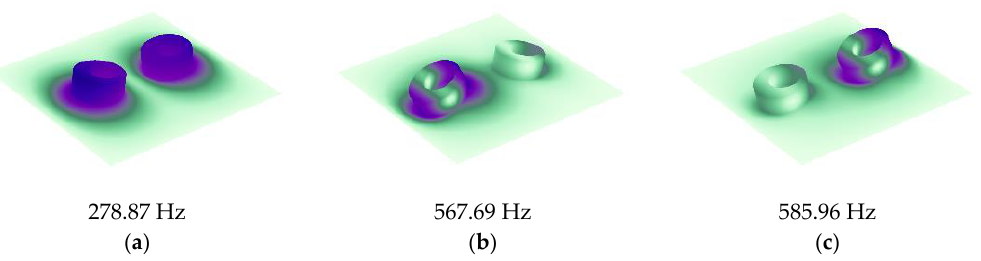
Figure 7. Eigenmodes of the double-mass-loaded membrane: ( a ) 278.87 Hz, ( b ) 567.69 Hz, and ( c ) 585.96 Hz. and ( c ) 585.96 Hz.